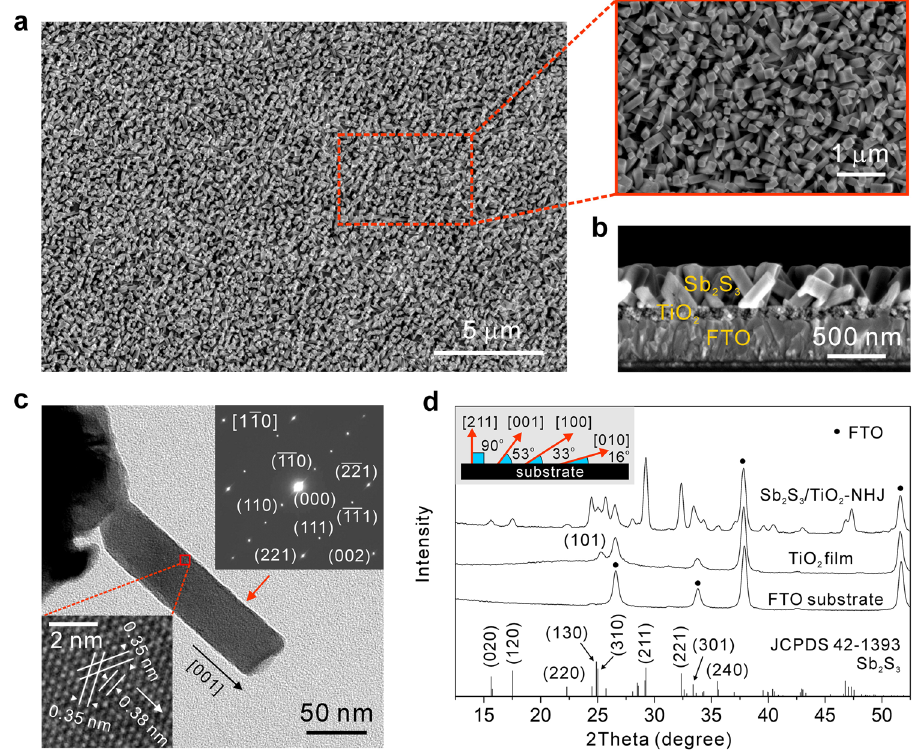
Fig. 2 Characterization of the Sb 2 S 3 nanorod array grown on TiO 2 fi lm. a Bird-view and ( b ) cross-sectional scanning electron microscopy images, ( c ) transmission electron microscopy (TEM) image, and ( d ) X-ray diffraction patterns. The insets to c are the selected area electron diffraction pattern (top- right) of the nanorod and the high-resolution TEM image from the marked part of the nanorod (bottom-left). Shown by the inset to d , the angle between a speci fi c Sb 2 S 3 crystal plane and the substrate is derived from the angle between the crystal plane and the Sb 2 S 3 [211] direction that is normal to the substrate plane. The Sb 2 S 3 nanorod array is prepared at the seed growth solution concentration of C sg = 0.1 M, the nanorod growth solution concentration of C ng = 0.8 M, and the repetition of spin-coating and annealing cycle number of n =